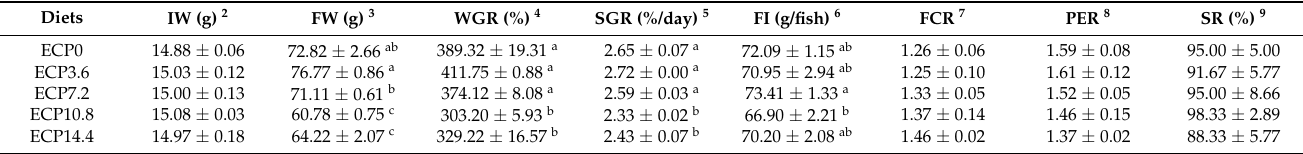
Table 1. Effect of replacing FM with ECP on growth performance of juvenile largemouth bass ( Micropterus salmoides ) 1